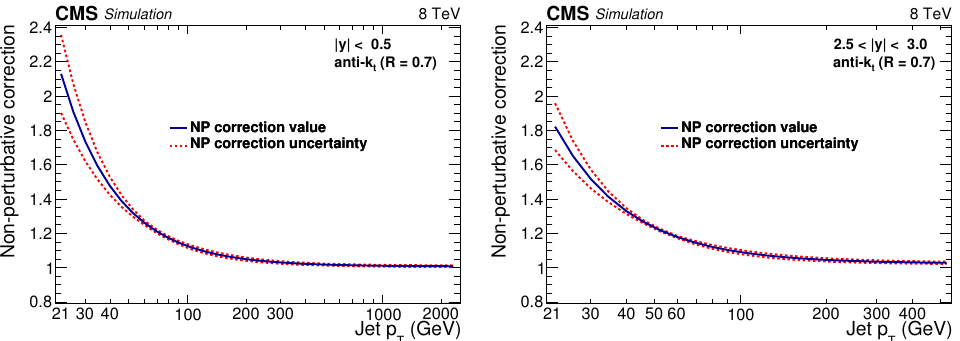
Figure 1 . The nonperturbative correction factor shown for the central (left) and outermost (right) absolute rapidity bins as a function of jet p T . The correction is obtained by averaging LO- and NLO-based predictions, and the envelope of these predictions is used as the uncertainty